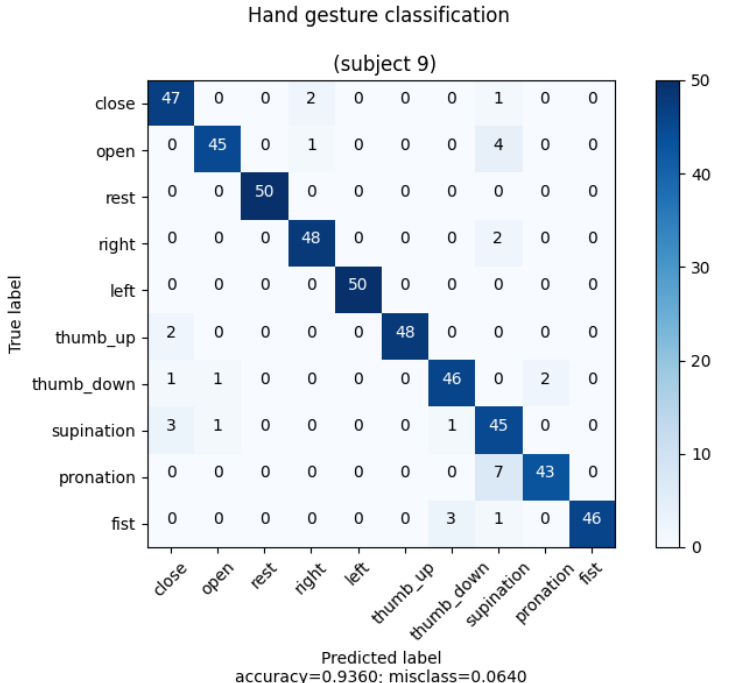
Figure A9. Confusion matrix of a subject who did not participate in data collection (subject 9).